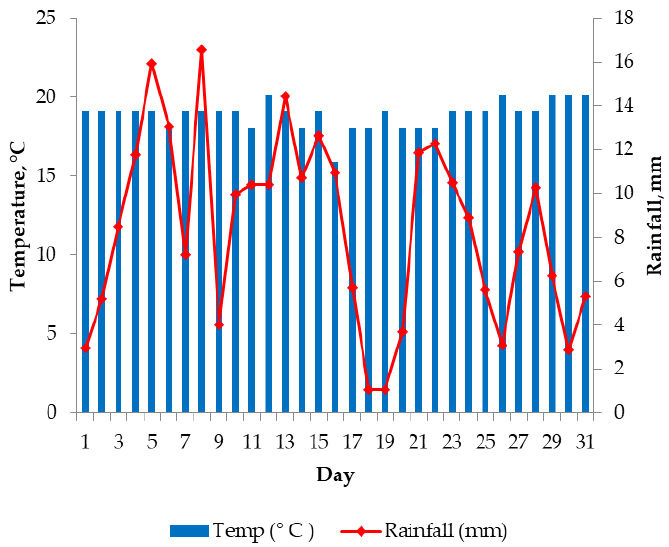
Figure 3. Daily mean temperature and rainfall data for the month of March, 2021.